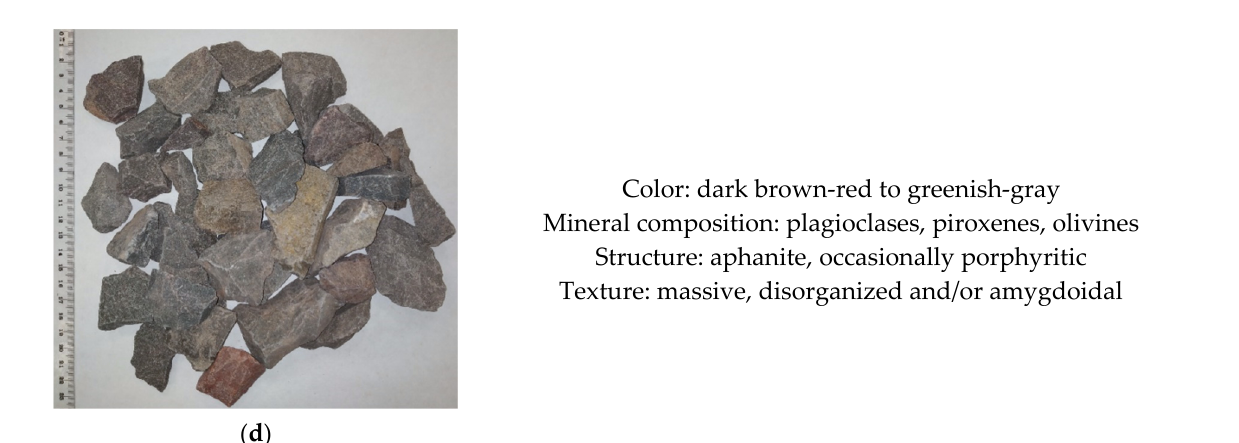
Figure 2. Petrographic characteristics of the investigated aggregates from igneous rocks: ( a )—BASALT 1; ( b )—BASALT 2; ( c )—GRANITE; ( d )—MELAPHYRE.